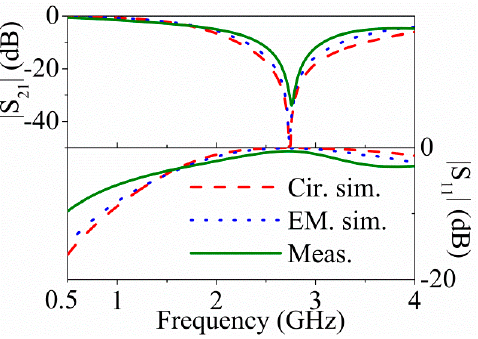
Figure 8. Electromagnetic simulation, circuit simulation and measurement response for the symmetric structure of Figure 7a. Reprinted with permission from [11].